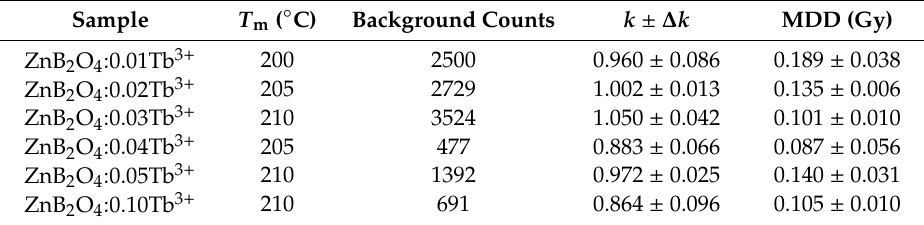
Figure 5. TL dose–response curves of (a) ZnB 2 O 4 :0.02Tb 3+ , (b) ZnB 2 O 4 :0.05Tb 3+ for 0.143–60 Gy beta dose range. The linear fit dose response is indicated by a solid line. Table 3. Dose responses and MDD values of ZnB 2 O 4 :Tb 3+ samples.